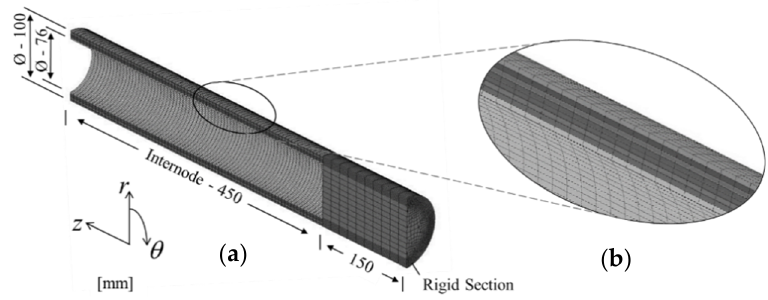
Figure 6. ( a ) Dimension outline of half-solid cylindrical model; ( b ) 8-layer wall-section.